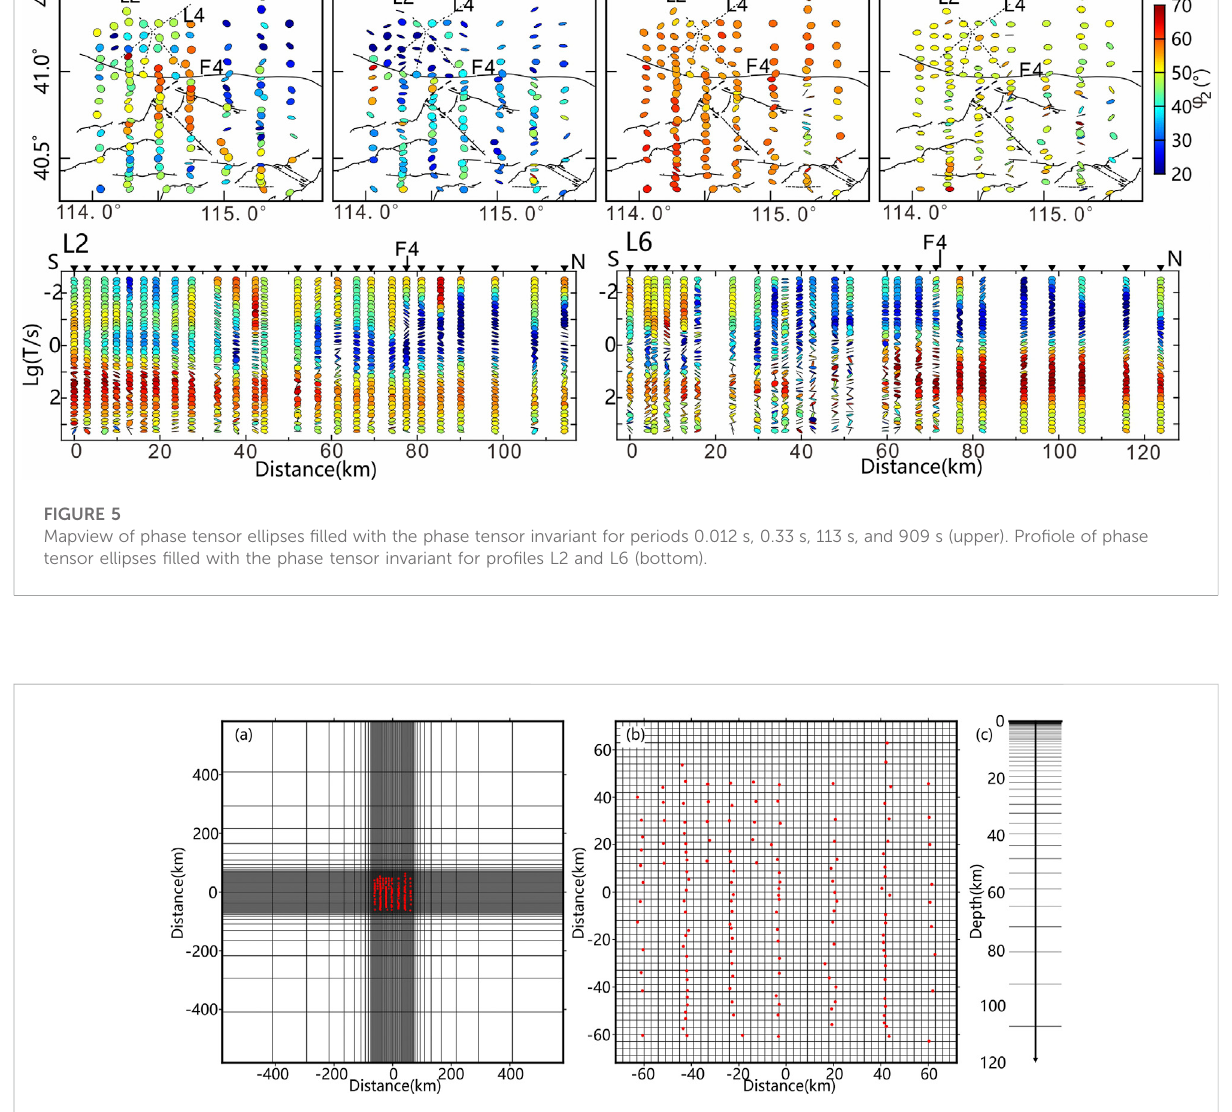
FIGURE 6 Grid used for the 3D inversion (A) Horizontal grid; (B) Horizontal grid of central part; (C) Vertical grid; The red dotes denote MT